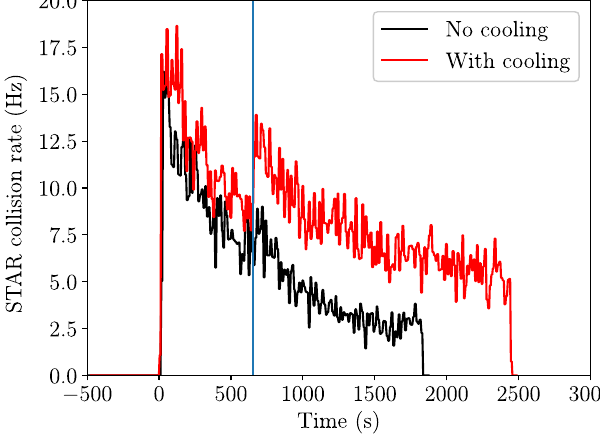
FIG. 6. Collision rates during stores at 3 . 85 GeV = nucleon, with (red trace) and without (black trace) cooling. The store length with cooling was usually about 10 min longer. The vertical line indicates the time when the β function at the collision point was squeezed, with